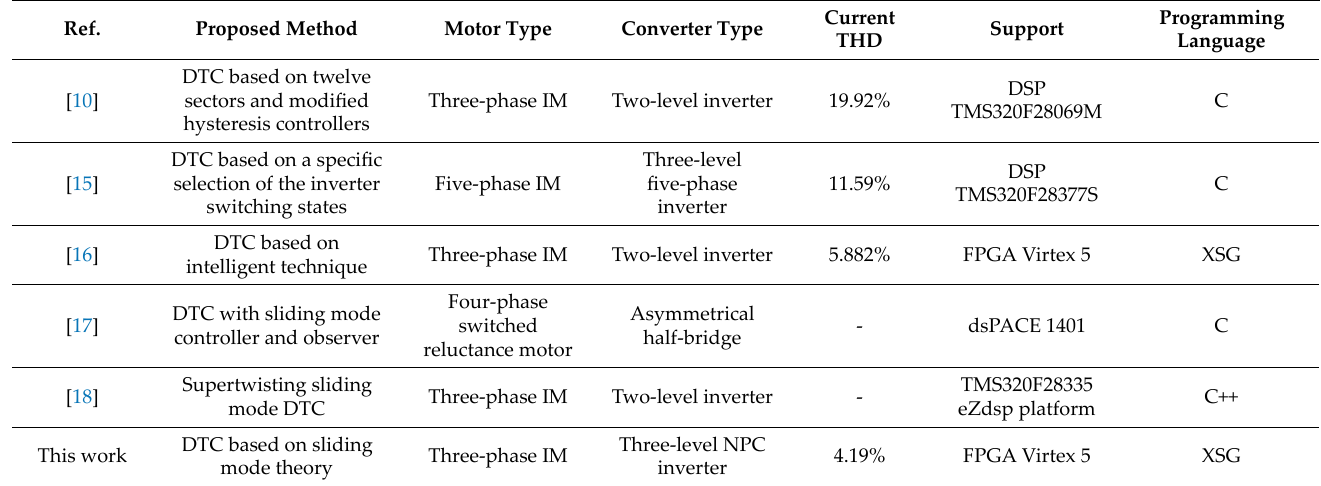
Table 1. Review of some proposed methods to improve DTC